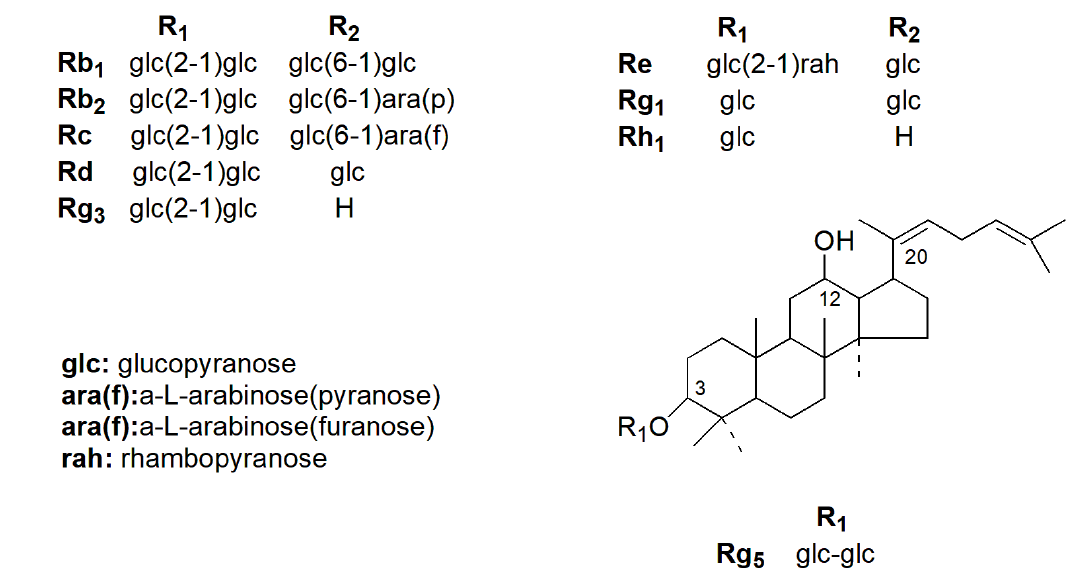
Figure 1. Structures of representative ginsenosides.